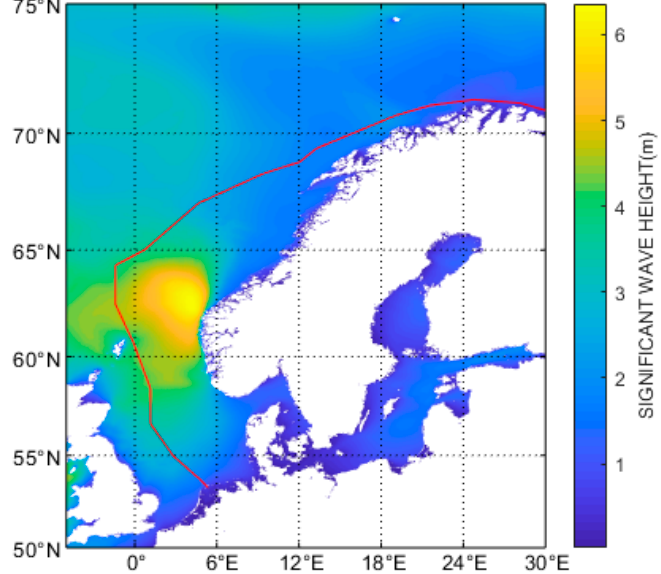
Figure 4. Wave height in the Norwegian Sea along the N2W voyage.